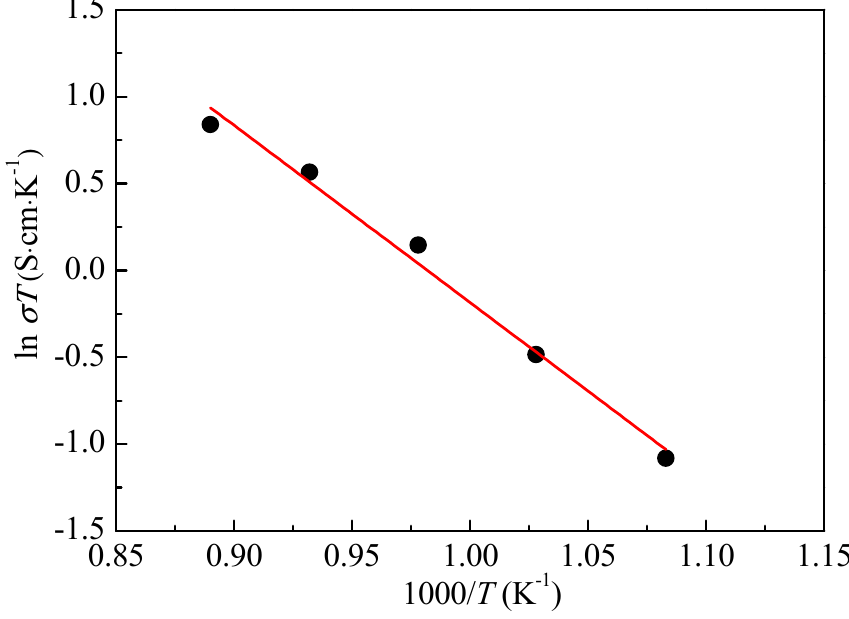
Figure 4. Arrhenius plots of ionic conductivity of the fabricated sample.